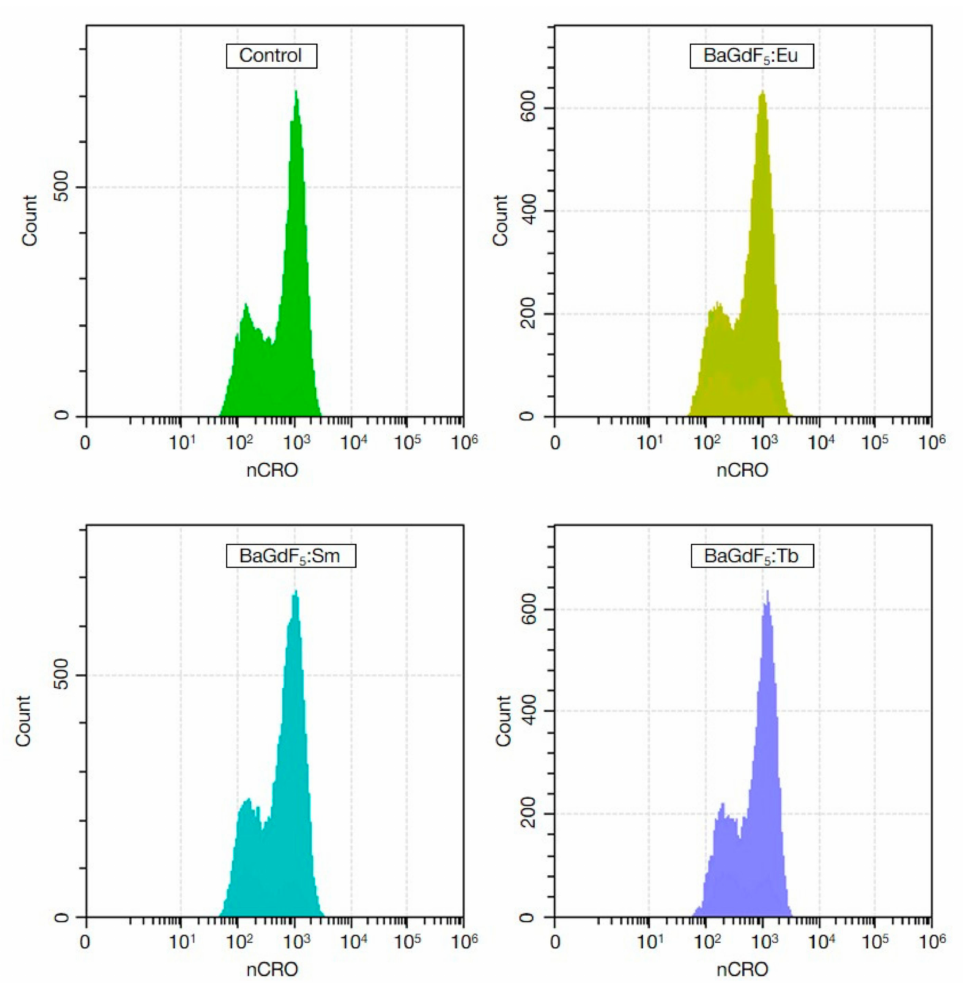
Figure 8. The histograms of cell distribution by nCRO+ signal intensity (ROS cytosol levels normal- ized by cell size) of K562 cells in the control group and after exposure to synthesized nanoagents with the final concentration of 50 µ g/mL for 1